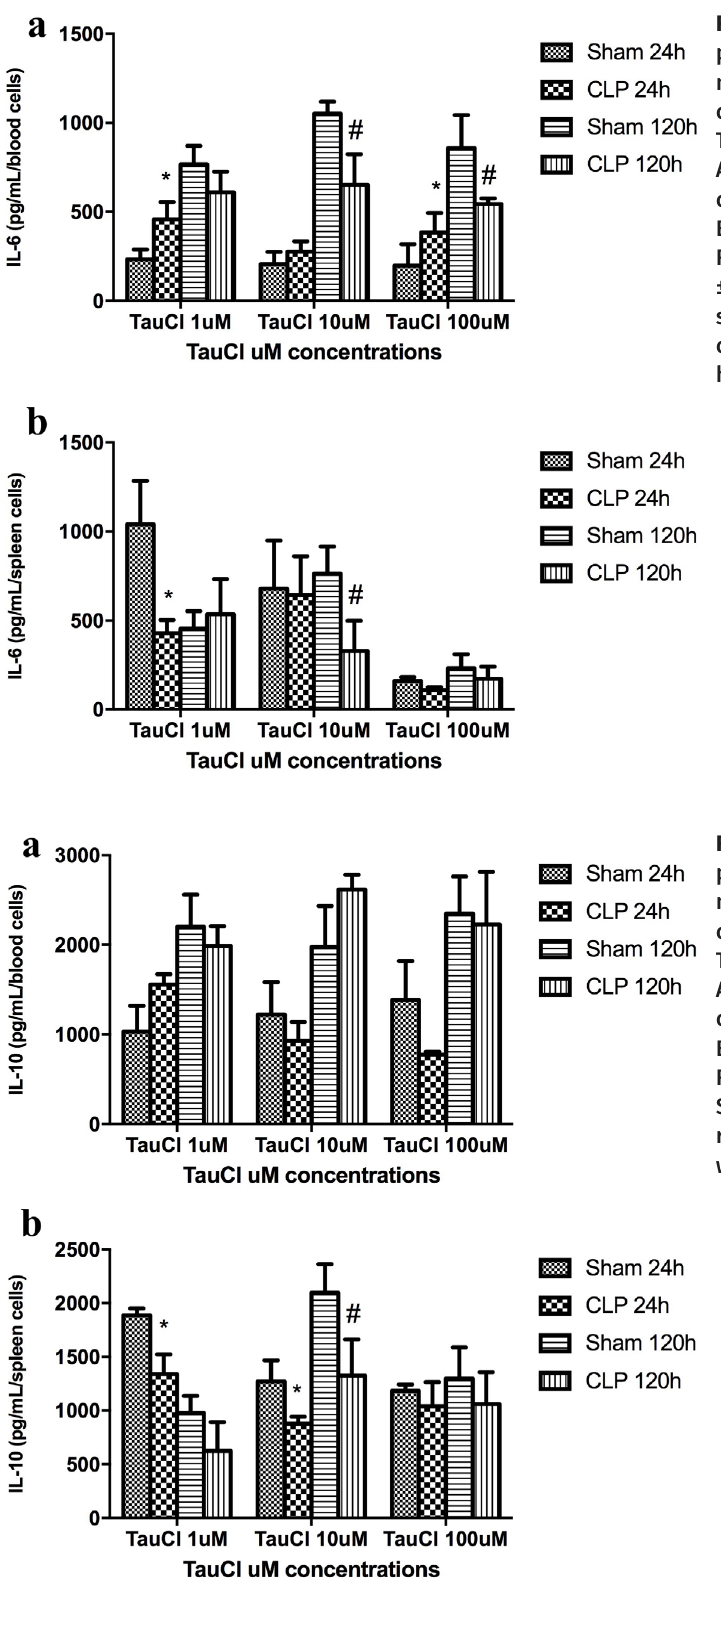
Figure 6. The effect of TauCl on the production of the pro-inflammatory mediator, IL-6. Lymphocytes (1x106 cells/mL) were preincubated with TauCl (1, 10 or 100 uM) for 1 hour.